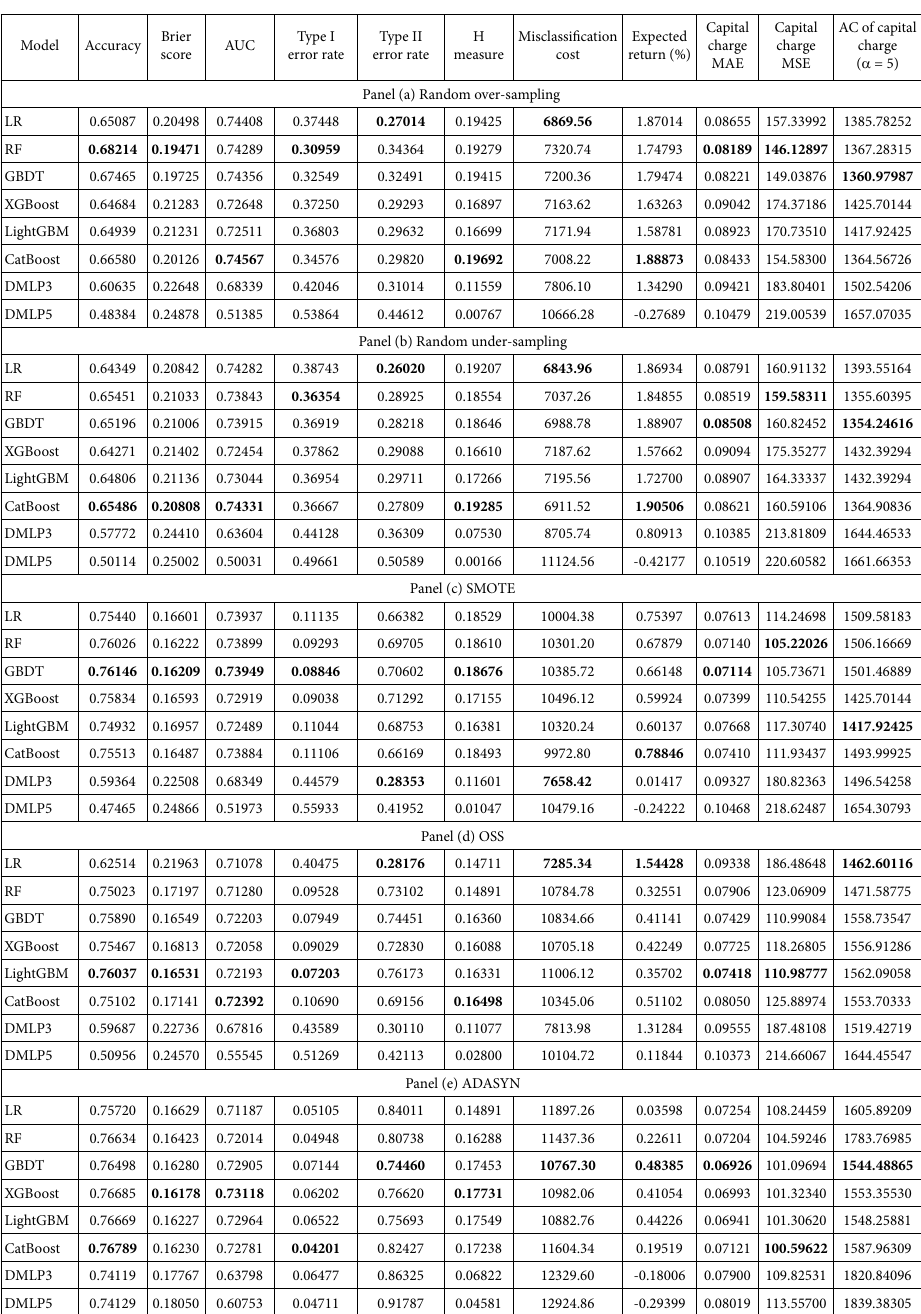
Table 6. Results of out-of-sample validation for Prosper dataset (with sampling techniques)